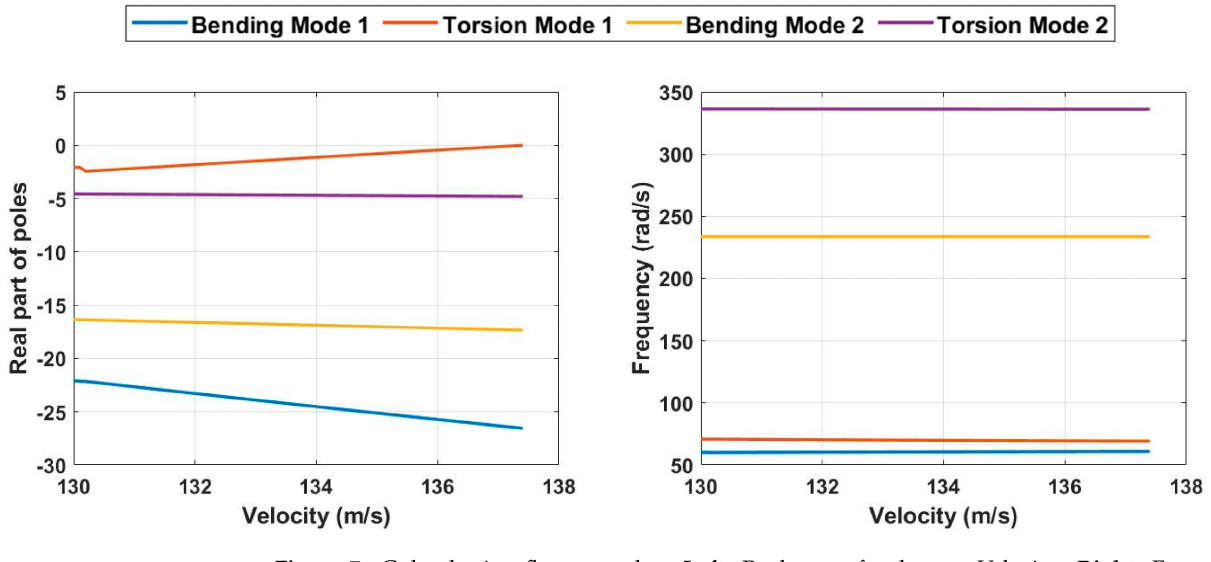
Figure 7. Goland wing flutter modes. Left : Real part of poles vs. Velocity. Right : Frequency vs. Velocity. Table 2. Comparison of calculated aeroelastic boundaries of Goland